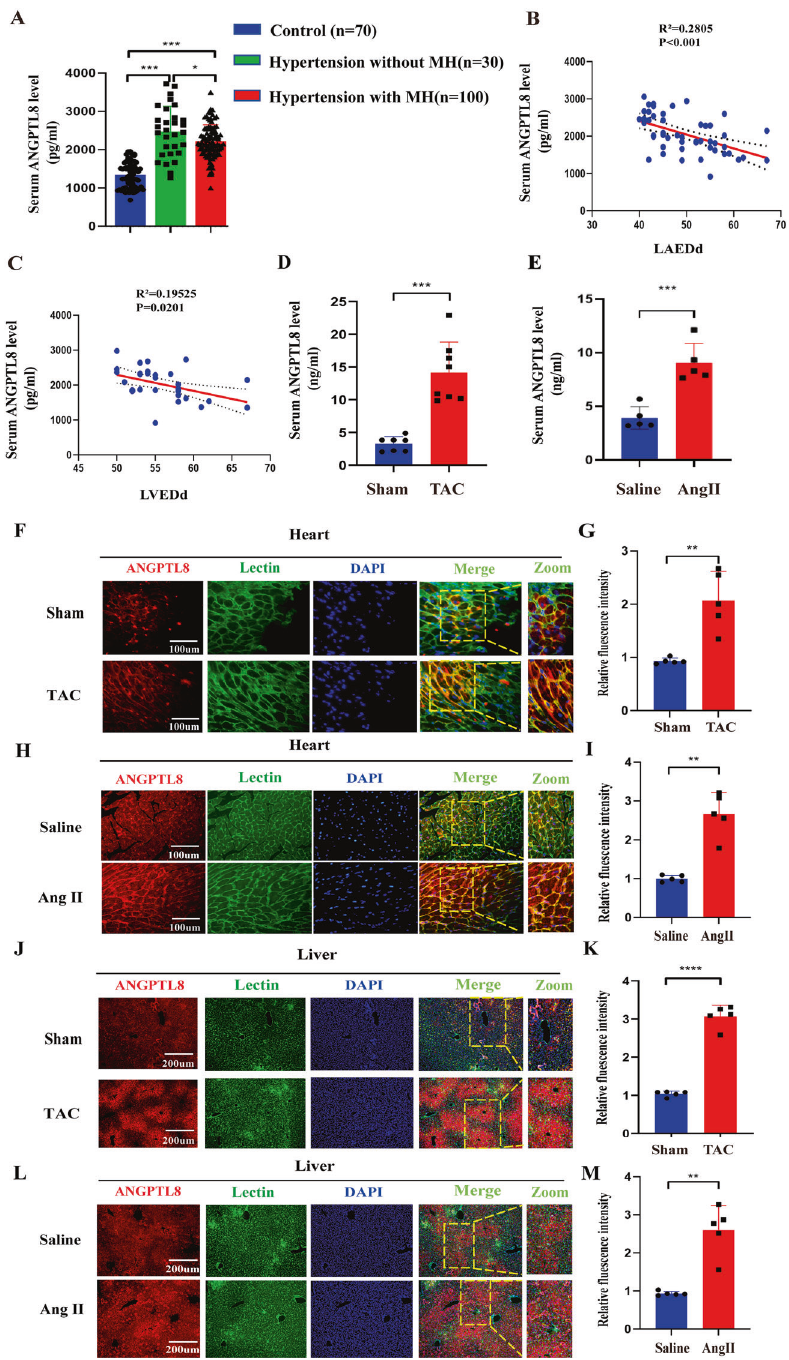
Fig. 1 Serum ANGPTL8 was increased in patients and animal models with cardiac hypertrophy. A Serum levels of ANGPTL8 in patients with hypertension ( n = 30), patients with hypertension and myocardial hypertrophy (MH) ( n = 100) and healthy people ( n = 70). B , C The correlation between serum ANGPTL8 level and left atrium diastolic diameter (LAEDd) ( n = 39) or left ventricular end diastolic diameter (LVEDd) ( n = 54) in the subjects with hypertensive patients and myocardial hypertrophy. Serum ANGPTL8 levels in mice subjected to TAC for 4 weeks ( D , n = 7 mice per group) and Ang II-infused mice ( E , n = 5 mice per group) were detected by ELISA ( ***P < 0.001 ). F Representative image of immuno fl uorescence with an anti-ANGPTL8 antibody in slices from TAC and sham mice ( n = 5 mice per group, scale bar, 100 μ m). G Quantitative results of the relative fl uorescence intensity of ANGPTL8 in the indicated groups ( n = 5 mice per group, scale bar, 100 μ m, ** P < 0.01). H , I Representative image and quantitative results of immuno fl uorescence with an anti-ANGPTL8 antibody in the indicated groups ( n = 5 mice per group, scale bar, 100 μ m, ** P < 0.01). J – M Representative immuno fl uorescence images and quantitative results of ANGPTL8 in slices from the indicated mouse livers ( n = 5 mice for the sham or TAC group; n = 5 mice for the saline or Ang II group, scale bar, 200 μ m, ** P < 0.01, **** P <